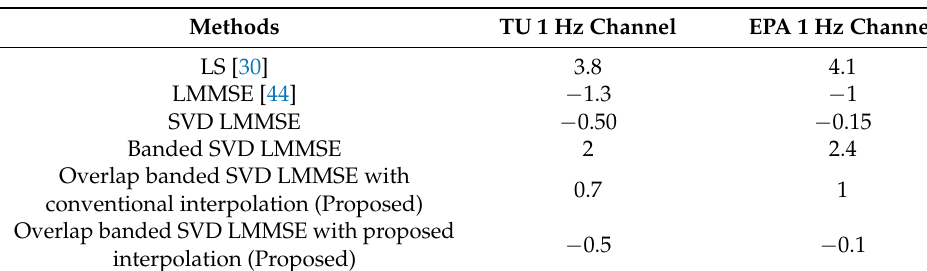
Figure 11 . Bit error rate (BER) comparison of the proposed technique for conventional and proposed interpolation meth- ods with traditional LMMSE and its other counterpart versions: ( a ) TU 1 Hz; ( b ) EPA 1 Hz.